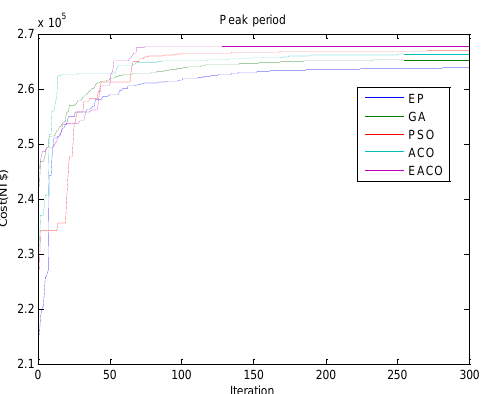
Figure 7. Convergence characteristics of EP, GA, PSO, ACO, and EACO during the peak period.